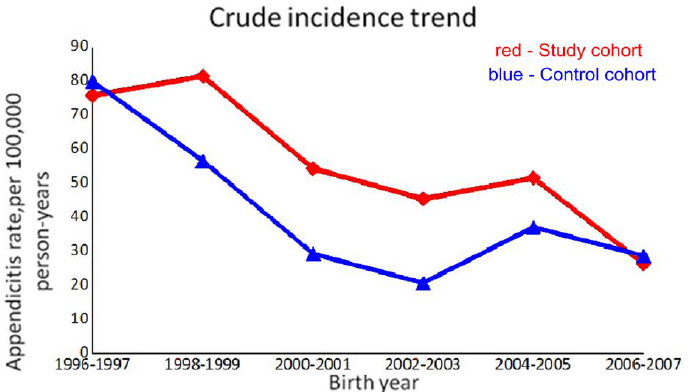
Figure 4. Trends of crude appendicitis incidence among 0–5 year children in both cohorts with birth year from 1996 to 2007. Table 4. Multivariate analysis of risk factors for pediatric appendicitis.